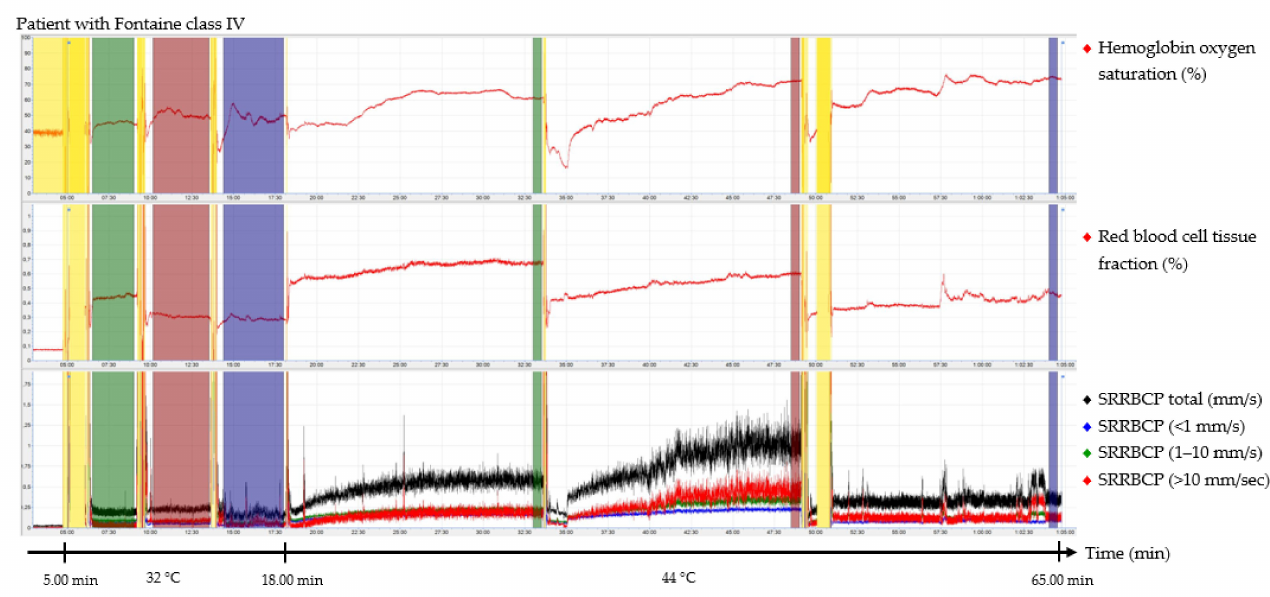
Figure 4. Continuous enhanced perfusion and oxygen saturation (EPOS) values of one patient with Fontaine class IV. Green times of interest (TOIs) are measurements on the dorsal side of the foot. Red TOIs are measurements on the medial side of the foot. Blue TOIs are measurements on the calf. Yellow regions are motion artifacts. All participants rested at least 5 min before recordings started. SRRBCP: speed-resolved red blood cell